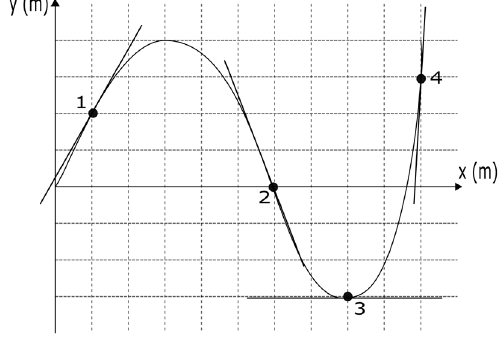
FIG. 1. Problem graph.